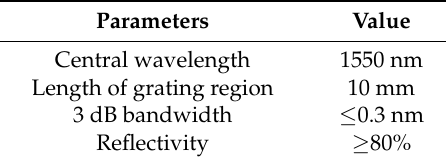
Table 1. Parameters of the grating.